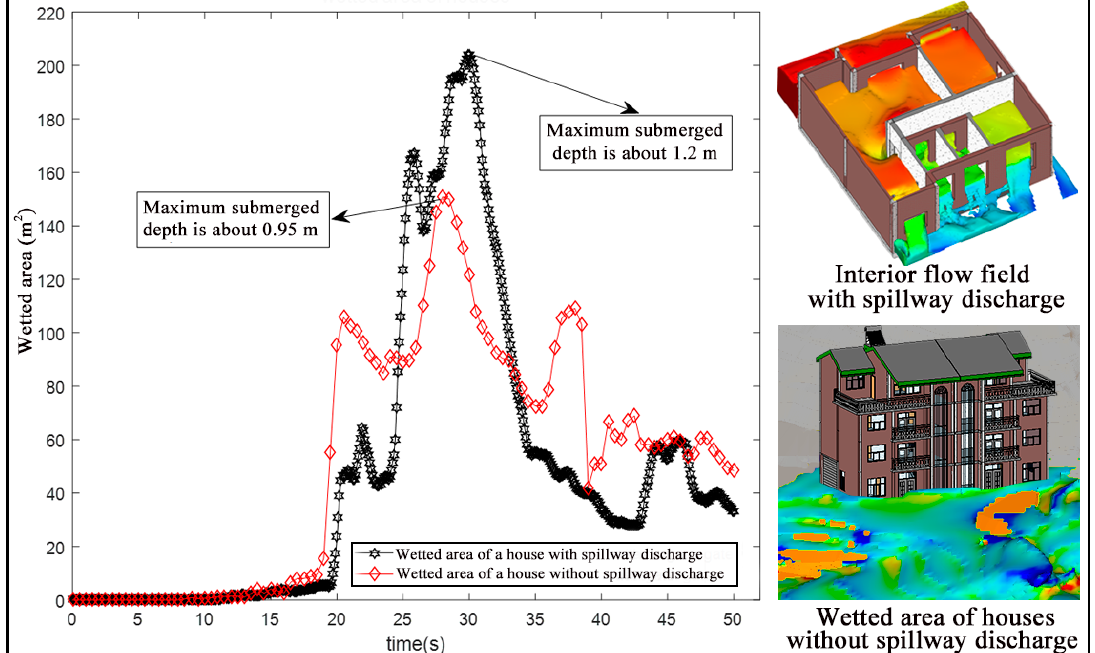
Figure 15. Wetted area of a house and the interior flow process under the normal water level.